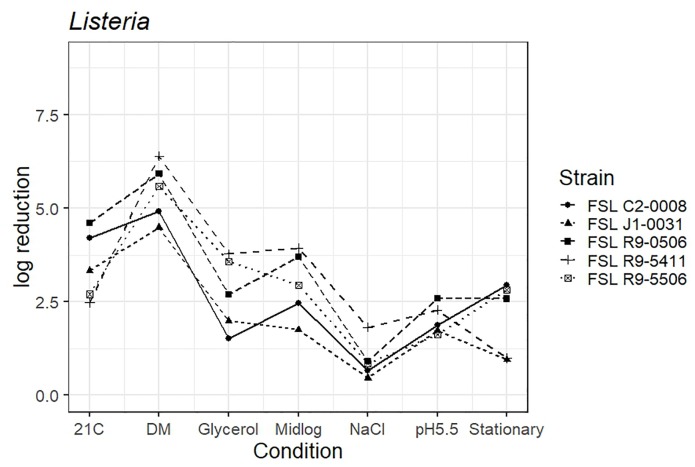
Average log reduction of four Listeria strains and one surrogate (L. innocua, FSL C2-0008) when pre-grown under different conditions prior to exposure to 60 ppm PAA for 45 s. Pre-growth conditions are shown on the X-axis and include pre-growth (i) at 21°C (21C), (ii) in defined minimal medium (DM), (iii) under reduced water activity (Glycerol), (iv) to mid-log phase (Midlog), (v) in 4.5% additional NaCl (NaCl), (vi) at pH 5.5 (pH5.5) and (vii) to stationary phase (Stationary). When calculating log reduction, values with count zero post-sanitizer treatment were substituted with the detection limit (e.g., 100 CFU/mL). Data represent averages from three trials; the standard deviation of the three trials and number of trials with values below detection limit after PAA exposure are listed in Supplementary Table 6.